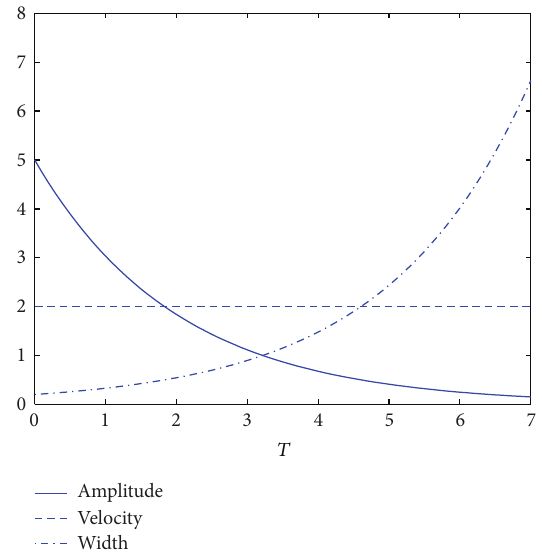
Figure 3: Variation of amplitude, velocity, and width due to the presence of dissipation